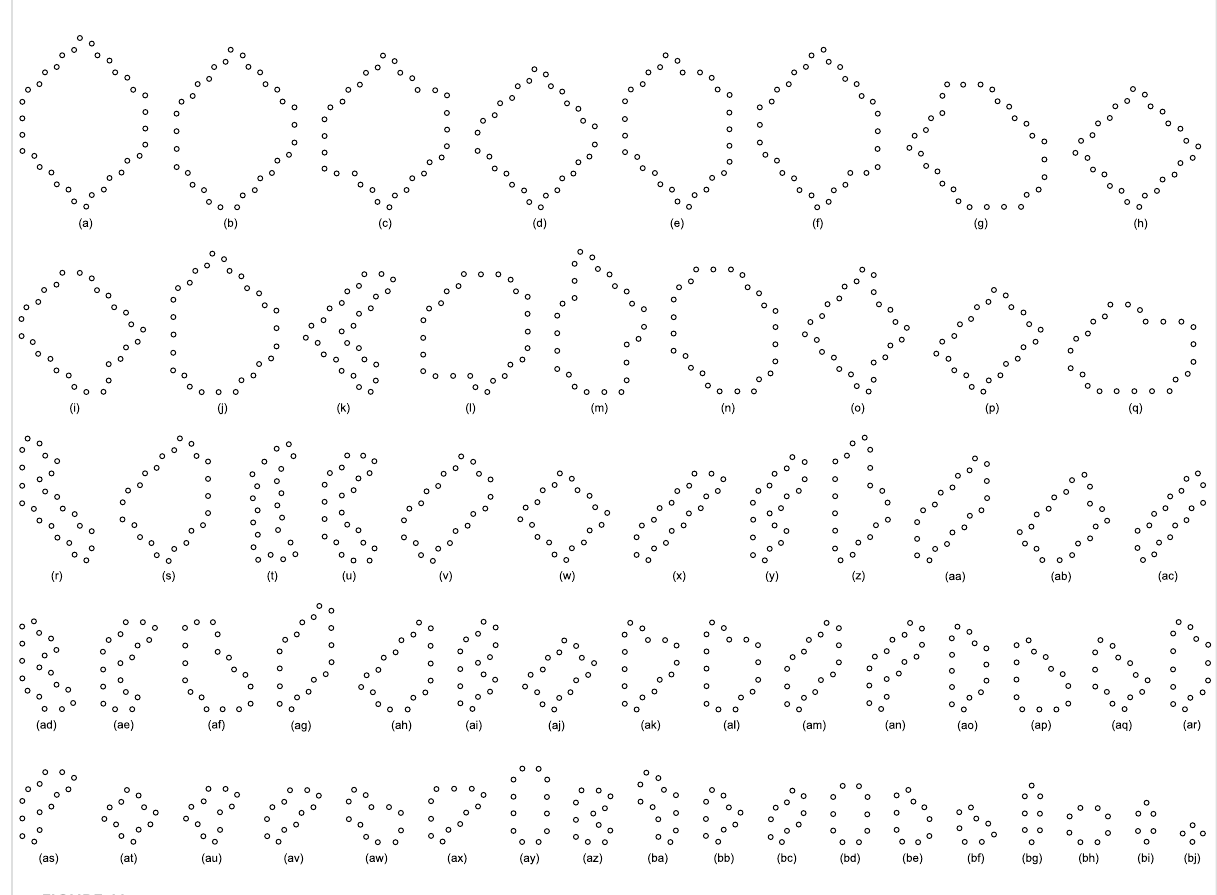
FIGURE 11 All fi nal loop structures starting from the con fi guration in Figure 7D by the greedy selection, adding, and changing